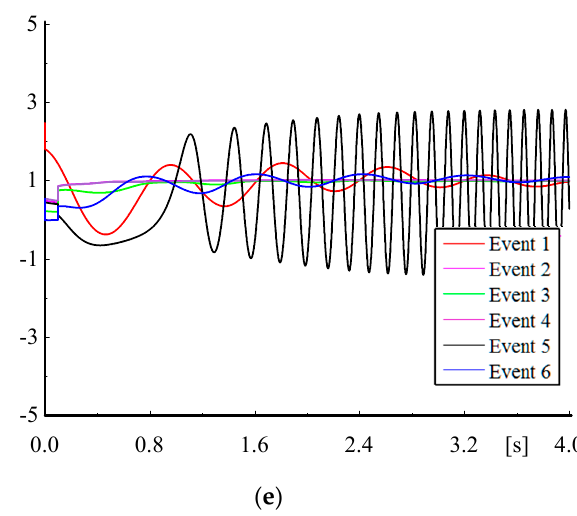
Figure 6. Normalized active power of Line 4–6 per steady-state value for events with a new fault location in various operation scenarios: ( a ) Scenario 1; ( b ) Scenario 2; ( c ) Scenario 3; ( d ) Scenario 4; ( e ) Scenario 5.